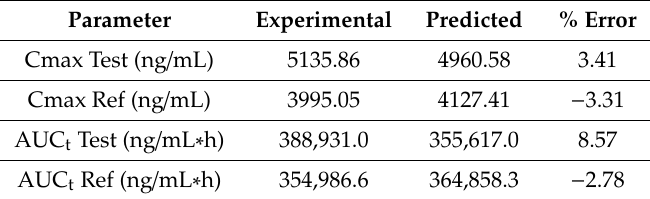
Table 6. Predictability analysis of the two-step IVIVC approach.